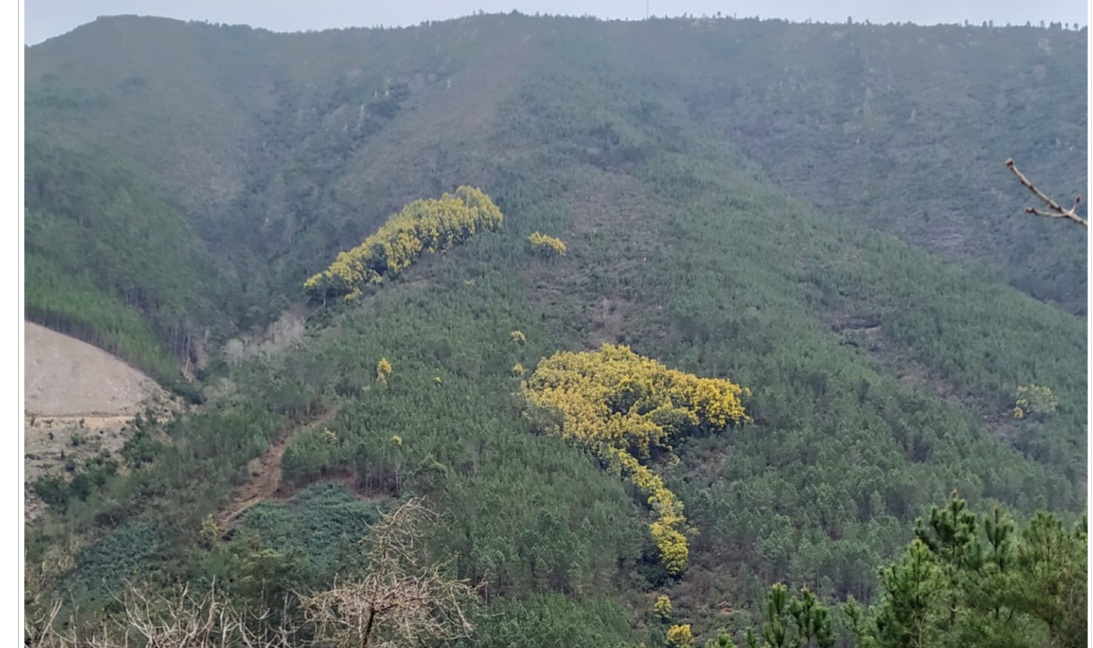
Figure 12. Stands of A. dealbata (photo obtained on 15 March 2021). The yellow color of the flowers makes the identification of the stands evident. It is possible to observe the development of the stand in the